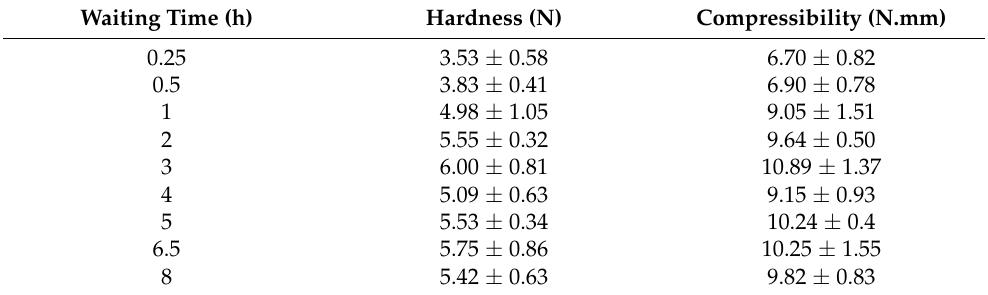
Table 2. Hardness and compressibility of the prepared mixture at different levels of waiting